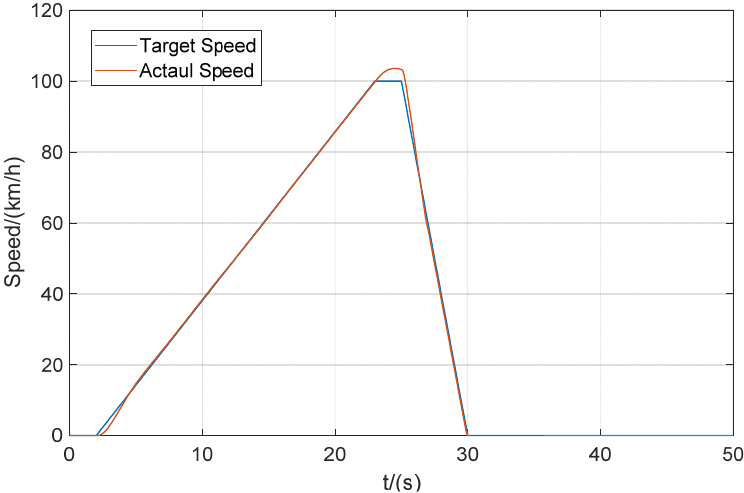
Figure 12. Target speed-time vs. actual speed-time.